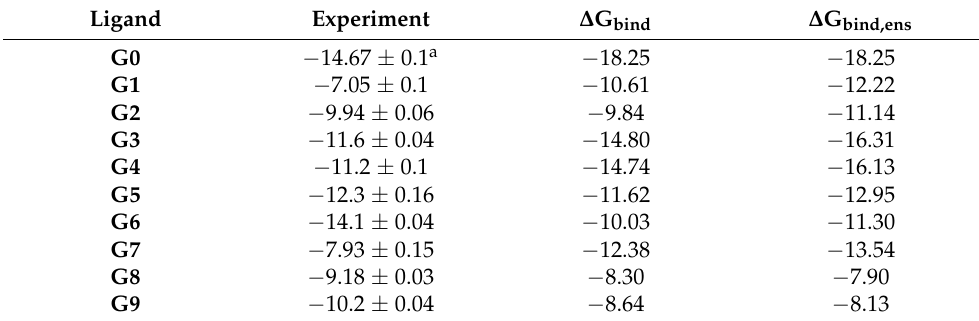
Figure 5. Top: Display of the 90 and 175 unique representatives of the CREs of the CB[8]*G8 and G9 complexes, respectively. The CB[8] receptor is not displayed. Bottom: Binding modes of the 10 top-ranked poses (CB[8] is displayed in cyan and wireframe for the sake of clarity). Table 2. Comparison of calculated GFN2-xTB Gibbs free energies of binding of ligands G0 – G9 (in kcal/mol) to the CB[8] receptor with experiment from ref